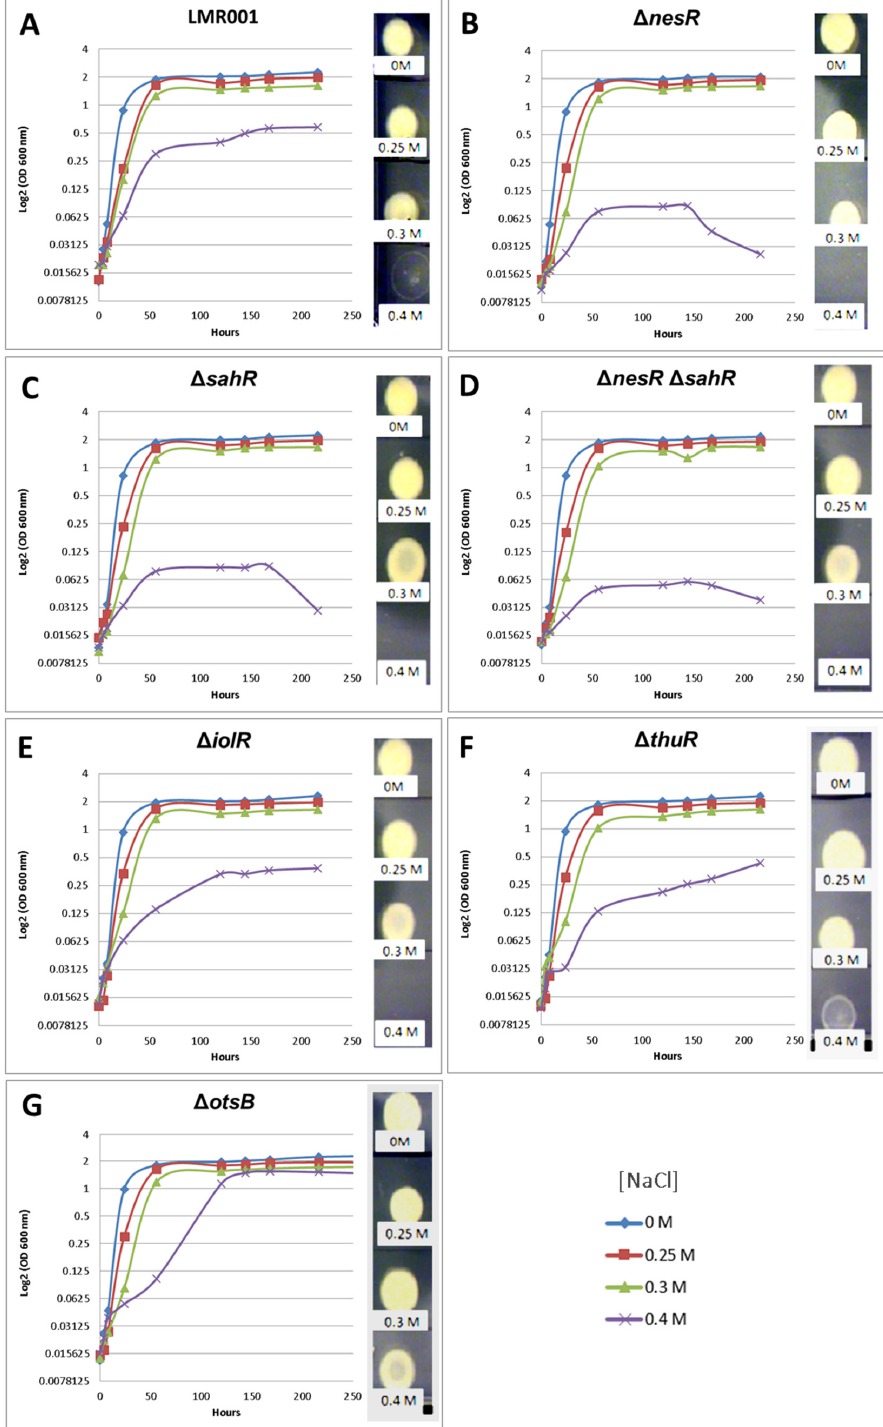
Figure 4. Effects of the mutations on salt tolerance. The growth kinetics are shown for the LMR001 ( A ), the strains Δ nesR ( B ), Δ sahR ( C ), Δ nesR Δ sahR ( D ), Δ iolR ( E ), Δ t huR ( F ), and Δ otsB ( G ) in TY complemented with 0, 0.25, 0.3, or 0.4 M of NaCl (color code indicated at the bottom right of the figure). The OD (600 nm) corresponding to the mean of three replicates is shown using log 2 scale up to 9 days of growth (line graphs), and 5 µ L of 2-week-old cultures was spotted onto TY to estimate long-term survival (pictures shown on the right of each line